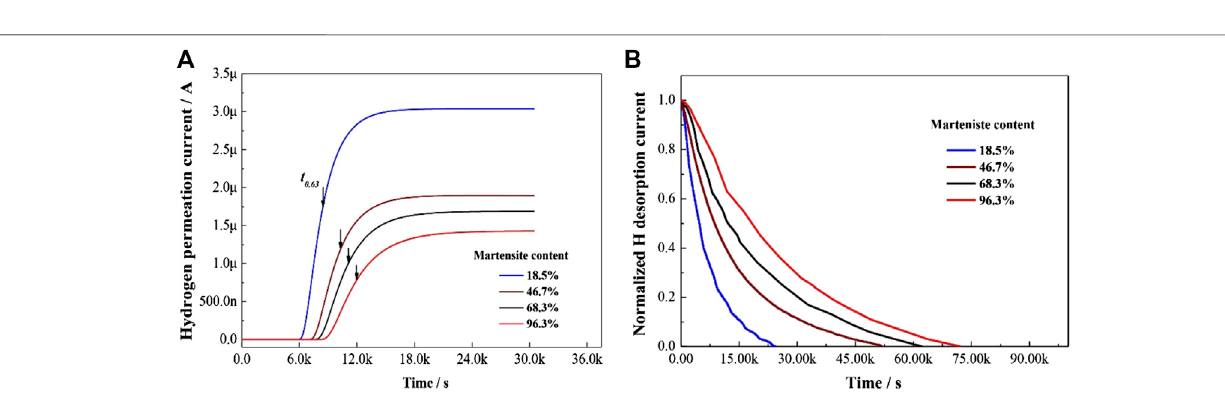
FIGURE 9 | Hydrogen permeation curves of DP samples: (A) Hydrogen permeation during charging step; and (B) hydrogen permeation during desorption step.